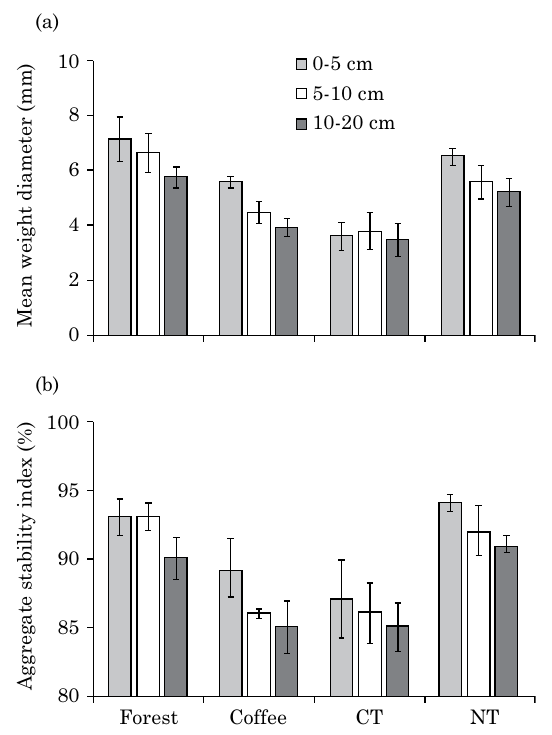
Figure 1. Mean weight diameter (a) and aggregate stability index (b) of a Brazilian Oxisol 24 years after forest conversion to a perennial crop with coffee or annual grain crops (maize and soybeans) in conventional tillage or no-tillage from three layers (0-5, 5-10 and 10-20 cm). Average of three replications. Bars indicate standard